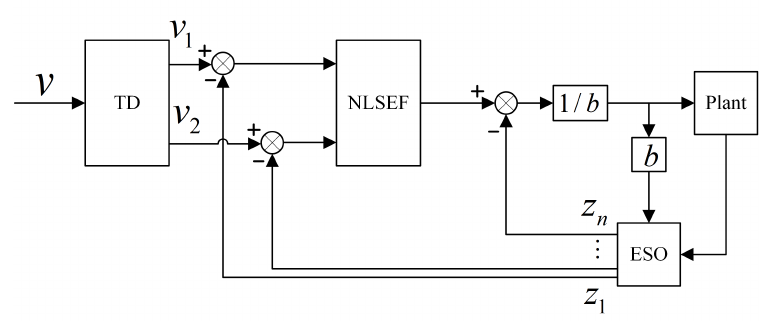
Figure 7. N-order ADRC